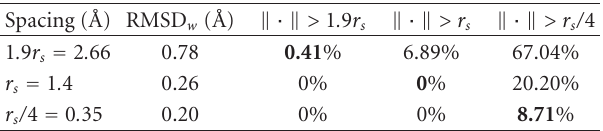
Table 3: RMSD and percentage of big di ff erences with reference